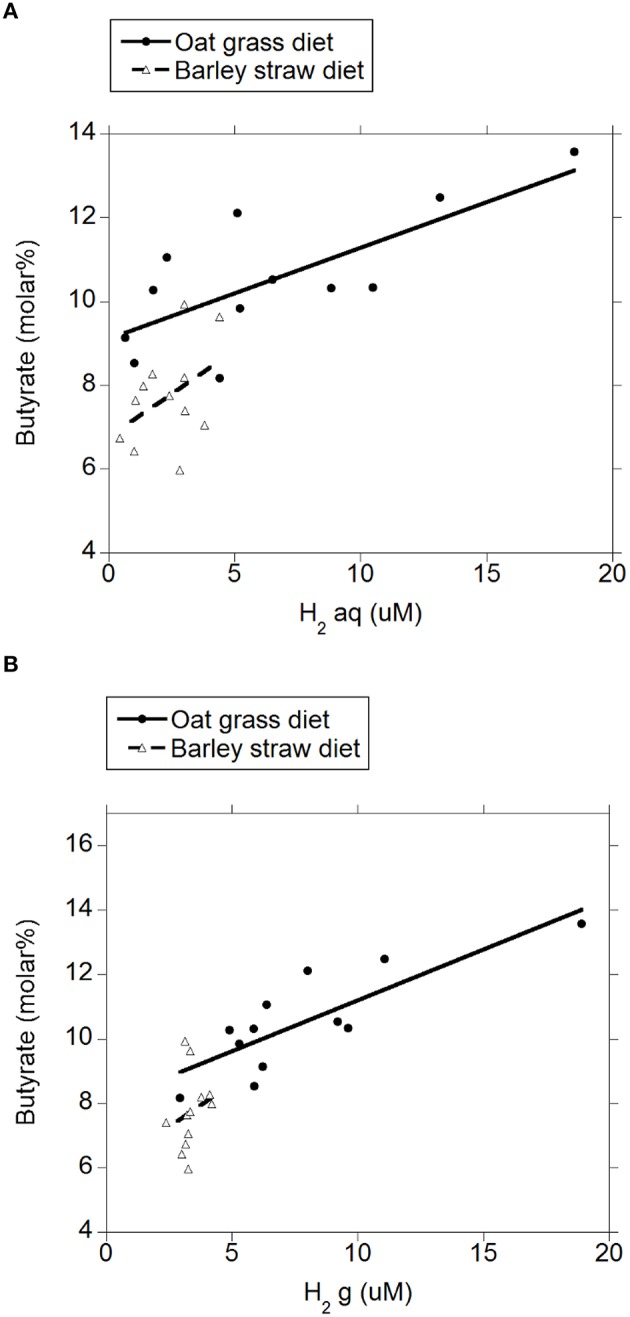
Relationship between butyrate molar percentage and concentration of dissolved and gaseous H2. (A) butyrate% = 8.14 (±0.35; P < 0.001) ± 0.92 (±0.26; P = 0.002) diet + 0.23 (±0.061; P = 0.001) H2 (aq); R2 = 0.71 (P < 0.001); (B) butyrate% = 7.35 (±0.48; P < 0.001) ±0.67 (±0.28; P = 0.025) diet + 0.32 (±0.077; P < 0.001) H2 (g); R2 = 0.66 (P < 0.001).